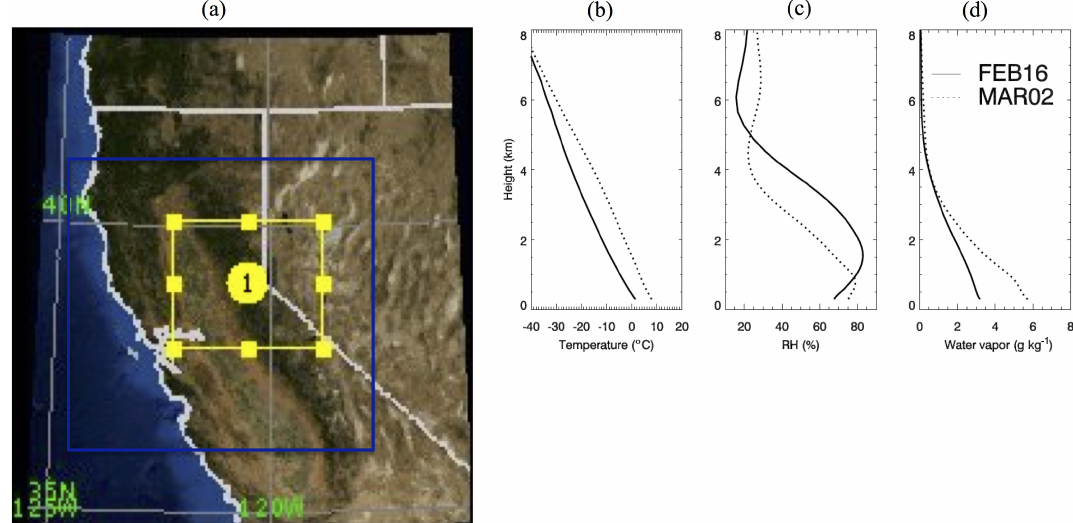
Figure 1. (a) The simulation domain (yellow box) and the vertical profiles of (b) the temperature, (c) RH, and (d) water vapor for the CMOC (FEB16) and WMOC (MAR02). (b) – (d) Domain mean values during the model simulation time periods. The blue box in (a) denotes the domain of 2km resolution simulations done in FAN2014.